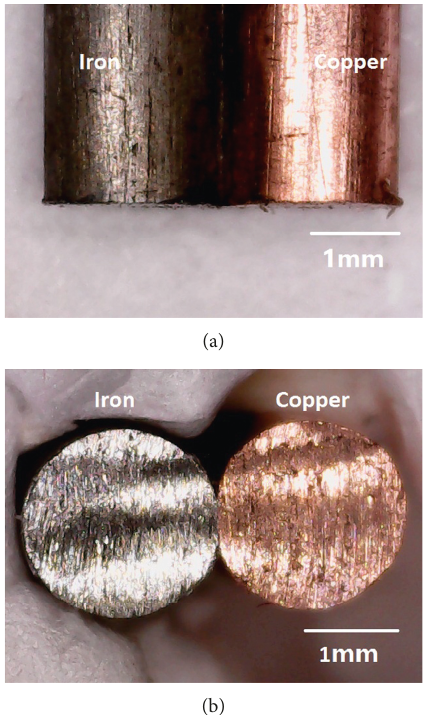
Figure 2: Fabricated multimaterial electrodes of iron and copper. (a) Side view. (b) Bottom